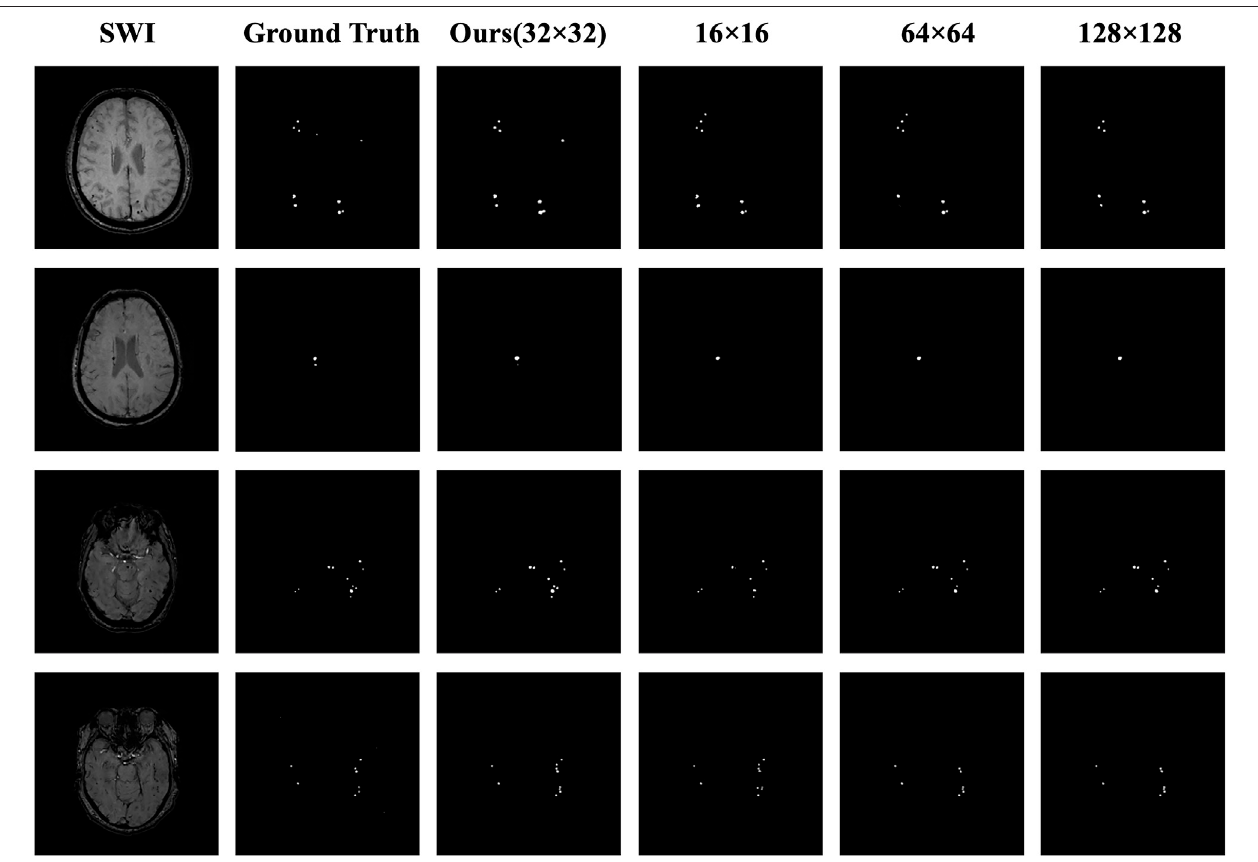
FIGURE6| ComparisonofthemasksforthefourROIsizes.Thecolumnsfromlefttorightrepresenttheoriginalimage,thegroundtruth,the32×32size(ours),the 16 × 16 size, the 64 × 64 size, and the 128 × 128 size; the rows from top to bottom represent case Nos. 1 – 4, respectively. In case 1, the lesion in the upper right corner was correctly predicted by using the 32 × 32 size, while using the other three sizes, the diagnosis was missed or a misdiagnosis was made. In case 2, the small lesion in the lower right corner was correctly predicted by using the 32 × 32 size, whereas using the other three sizes, the diagnosis wasmissed. In case 3, the number and distributionofthelesionswerecorrectlypredictedusingthe32×32size,whereasusingtheotherthreesizes,thediagnosiswasmissed.Incase4,theresultusingthe32 × 32 size was closest to the number and distribution of the ground truth, while using the other three sizes resulted in missed diagnoses or made misdiagnoses.